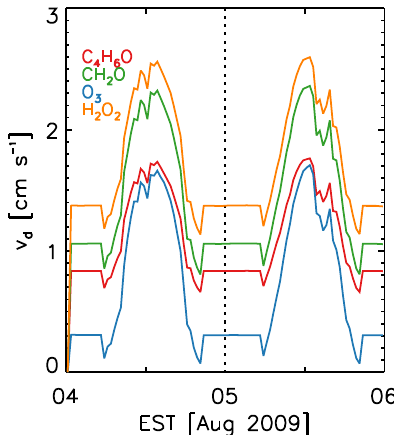
Fig. 1. Simulated canopy-integrated deposition velocity ( v d ) for methacrolein (C 4 H 6 O), formaldehyde (CH 2 O), ozone (O 3 ), and hy- drogen peroxide (H 2 O 2